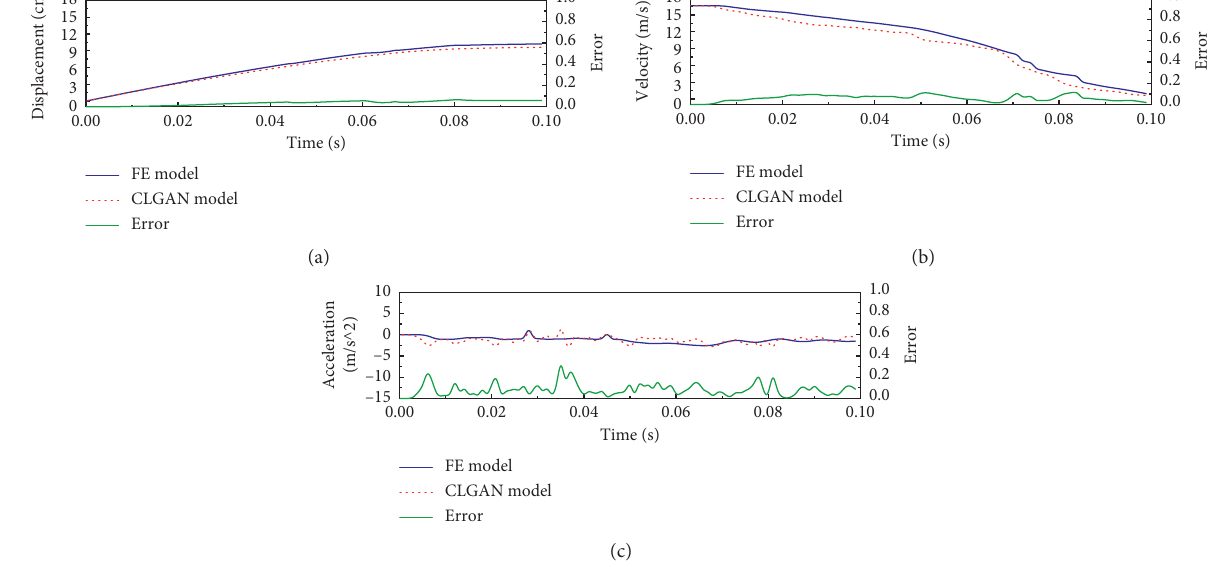
Figure 17: Comparison of the head car crash dynamic characteristics. (a) Displacement comparison of CLGAN model and FE model. (b) Velocity comparison of CLGAN model and FE model. (c) Acceleration comparison of CLGAN model and FE model.